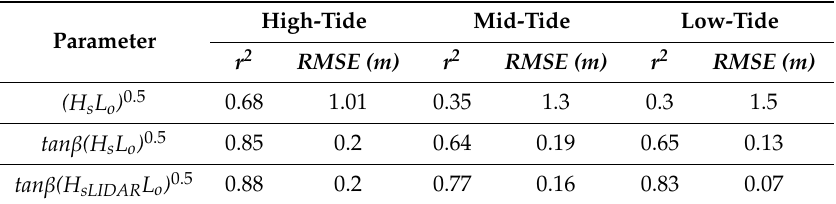
Table 1. Statistical results of the linear regression between R s and three different dimensional versions of an Iribarren-based relationship.